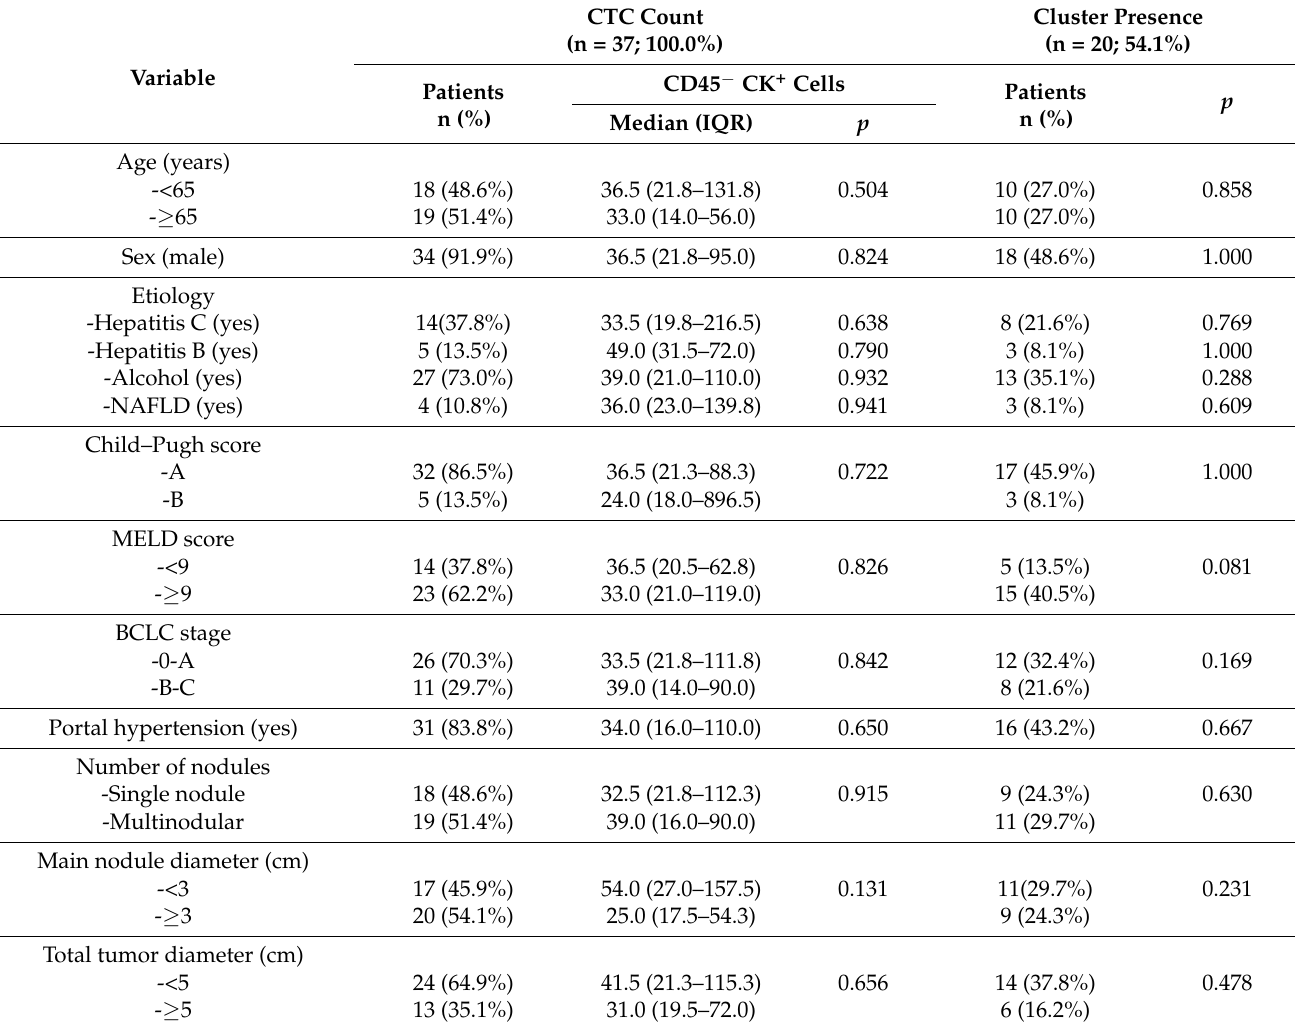
Table 2. Relationship between clinicopathological characteristics and liquid biopsy findings, includ- ing individual count of circulating tumor cells and presence/absence of clusters of circulating tumor